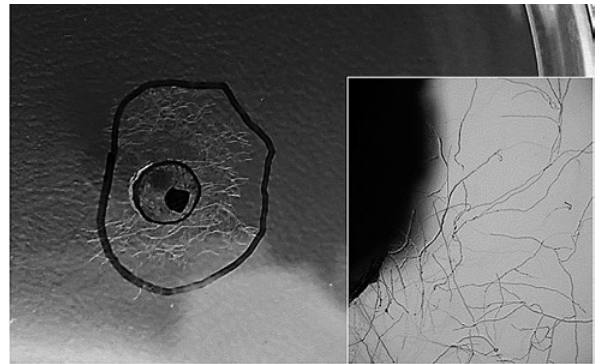
Figure 4. Detail of inhibited growth of strain Ds 99-7 on PDA plates amended with 50% of Fus cultural filtrate (Fus CF), observed with a microscope at 8 dpi. The mycelium rarely formed and had sparse hyphae.